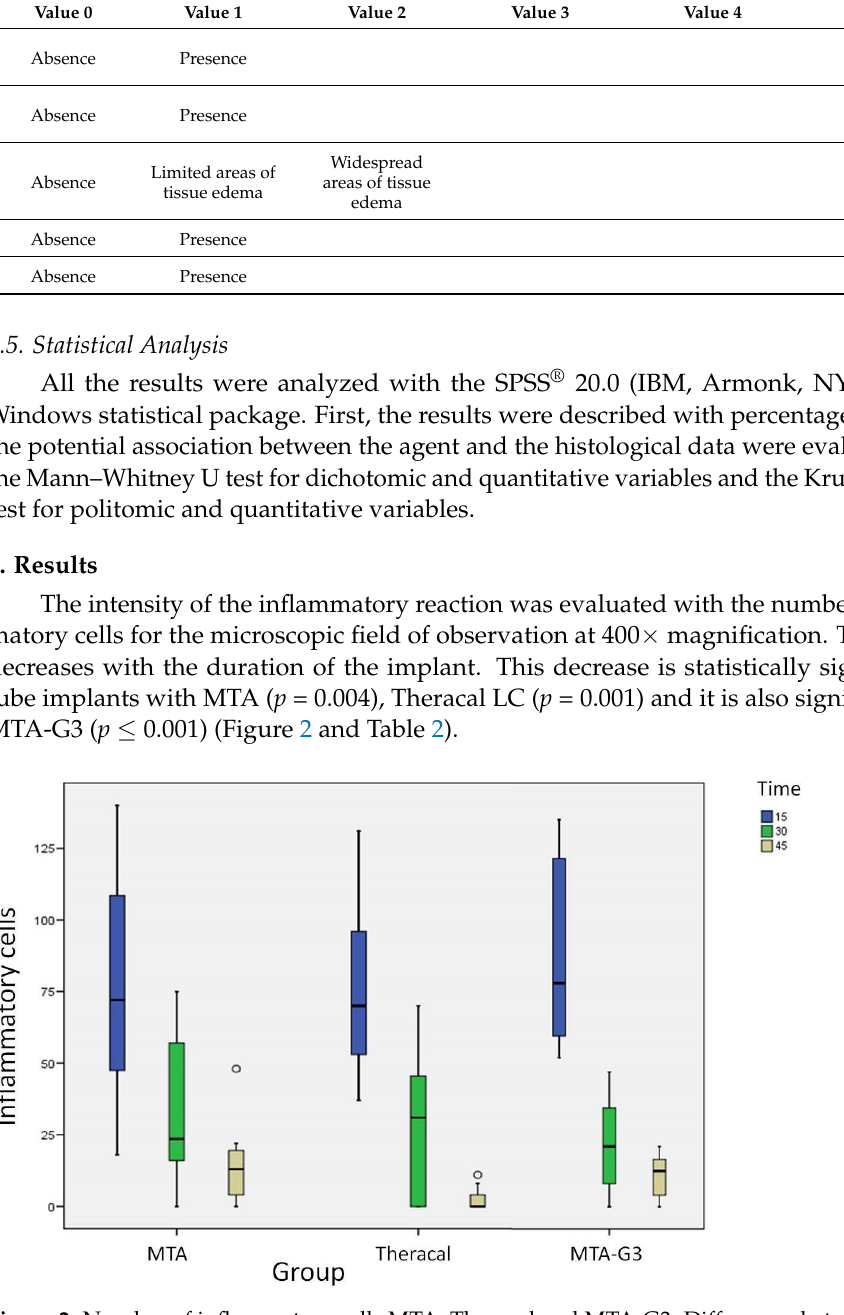
Figure 2. Number of inflammatory cells MTA, Theracal and MTA-G3. Differences between periods. The density decreases with the duration of the implant.